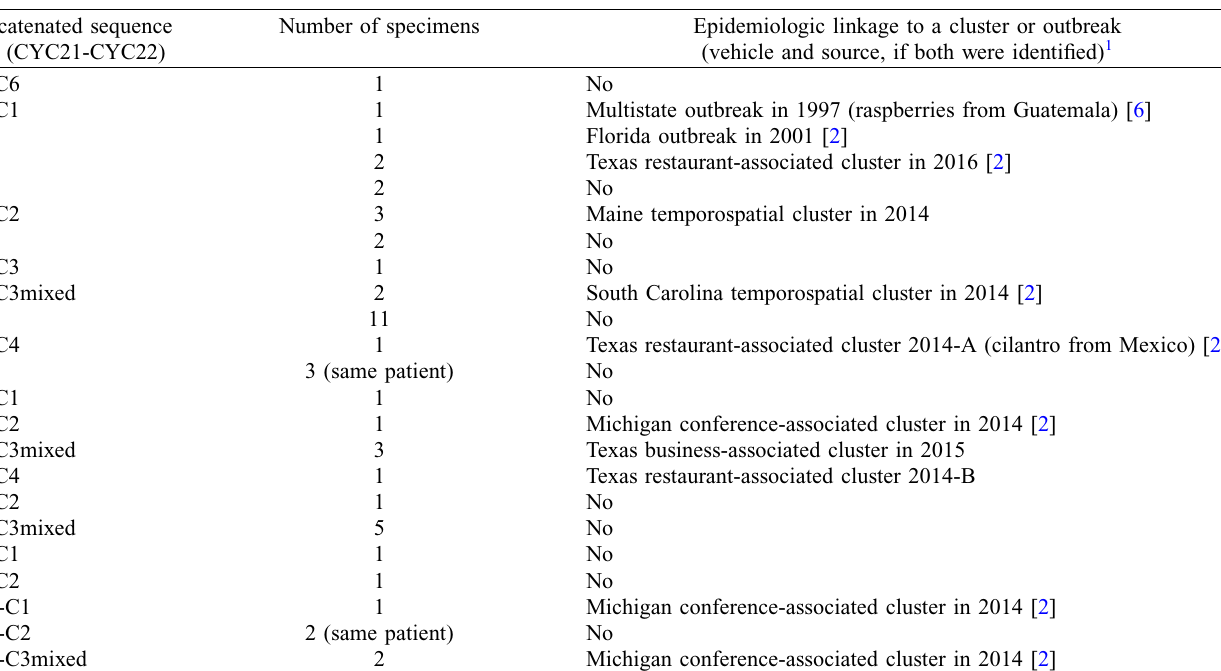
Table 2. Concatenated sequence types observed among 49 stool specimens (from 46 patients) with typing results for both loci CYC21 and